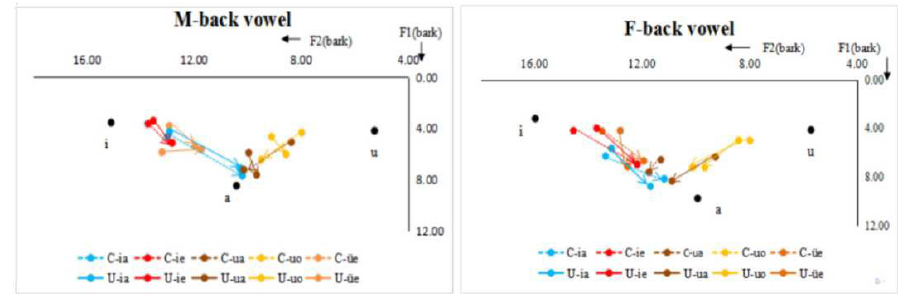
Fig. 3 Acoustic vowel map of post-sound vowels for learners with primary level and standard speakers.